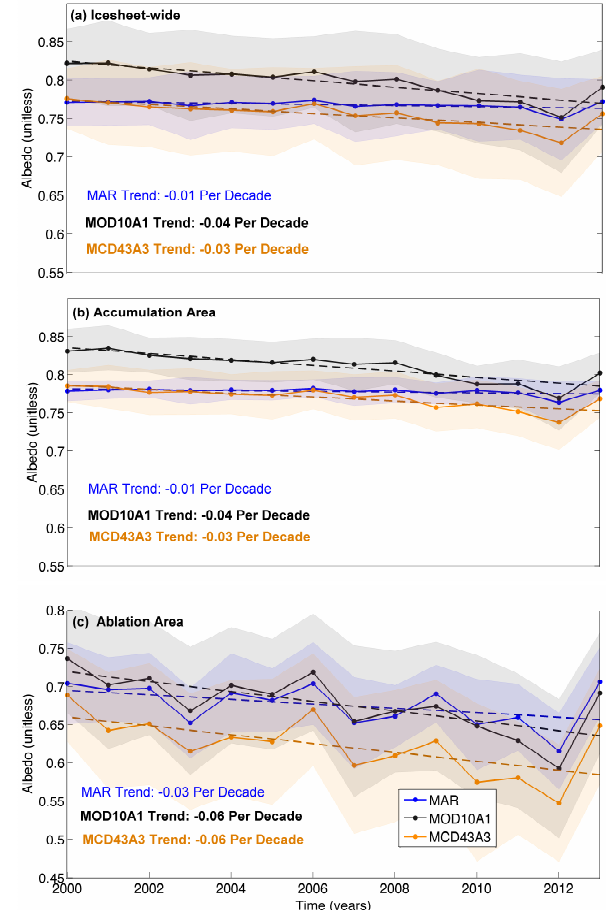
Figure 14. Mean annual JJA ice sheet albedo (solid lines) simulated by MAR v3.2 (clear-sky; blue), MOD10A1 (black) and MCD43A3 BSA SW (orange) for 2000–2013 and best linear fit (dashed lines) for (a) the entire ice sheet, (b) the accumulation zone, and (c) the ablation zone defined with MAR v3.2. The trends shown are sta- tistically significant at the 95% confidence level for the MODIS products, but are not statistically significant for MAR. Shaded areas show annual JJA standard deviation of albedo for 16-day periods from each data set. Note that the y axis interval is the same for all graphs, but is shifted by 0.1 for (c)